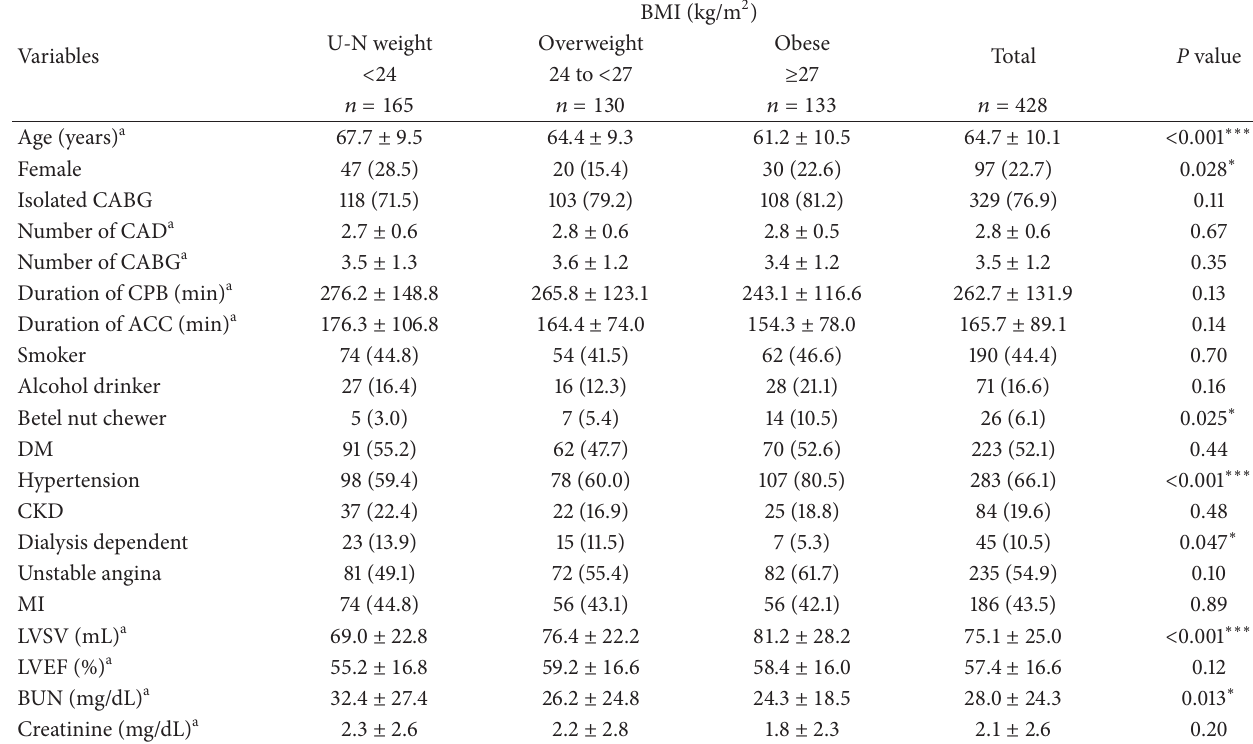
Table 1: Comparison of the operative risk factors in the BMI